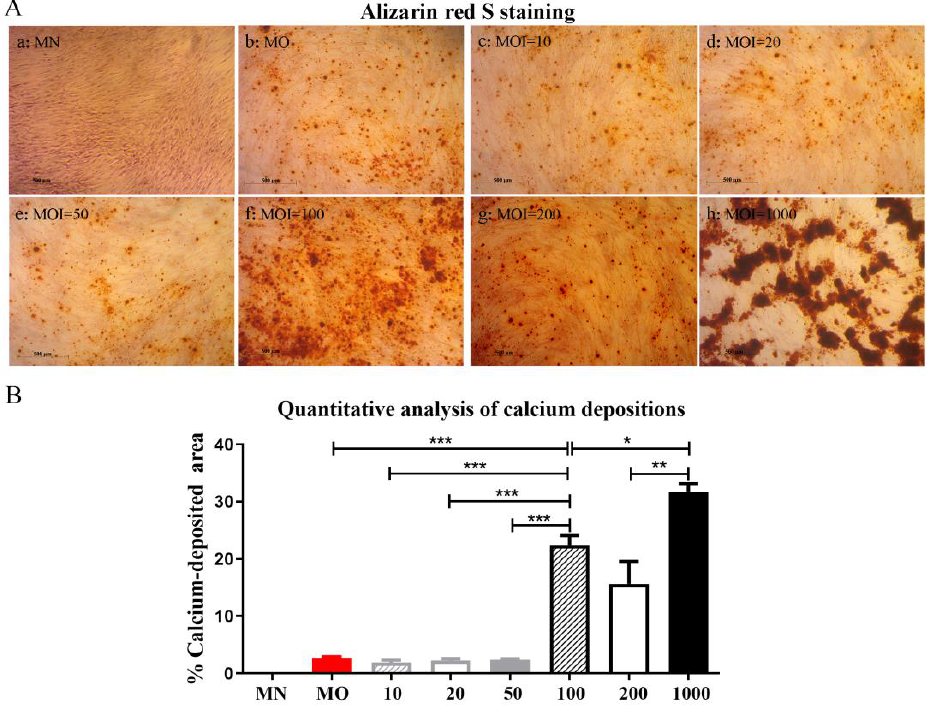
Figure 2. Analysis of calcium deposition within Ad.hBMP-2-transduced hADSCs using different MOI after 4 weeks in monolayer culture: ( A ): Micrographs, Alizarin red S staining. ( a ) MN; ( b ) MO; ( c ) MOI = 10; ( d ) MOI = 20; ( e ) MOI = 50; ( f ) MOI = 100; ( g ) MOI = 200; ( h ) MOI = 1000. Scale bar = 1 mm. ( B ) Morphometric analysis. Calcium was not detected in the MN group. hADSCs transduced with MOI of 100 and 1000 deposited significantly more calcium than the other groups. Most calcium depositions were observed in the group transduced with an MOI of 1000. (* for p < 0.05, ** for p < 0.01 and *** for p <